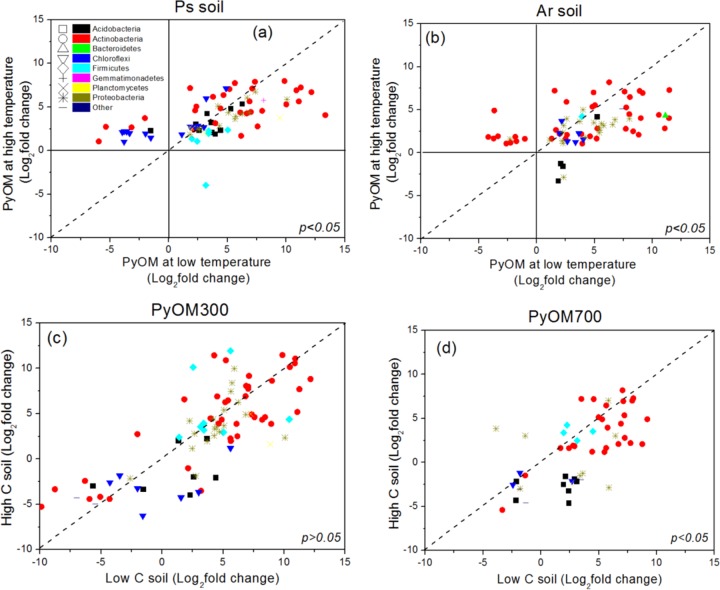
Log2-fold change in relative abundance of differentially abundant OTUs in PyOM300 and PyOM700 (a and b) and in Ps soil and Ar soil (c and d). Each dot represents a single OTU. Differentially abundant OTUs that were not significantly different (with Log2-fold change of <1 or adjusted P values of >0.1) compared with soil control are not presented in each figure. Dashed lines indicate that the preferences of OTUs for low- and high-pyrolysis-temperature PyOMs were equivalent. The OTUs indicated below the dashed lines preferred low-pyrolysis-temperature PyOM to high-pyrolysis-temperature PyOM, whereas the OTUs indicated above the dashed lines showed the opposite trend. t tests were conducted to show the statistically significant differences (P < 0.05) in the values of Log2-fold change between two PyOMs and between two soils. P values of <0.05 in panels a and b indicate that the whole bacterial community tended to thrive better on low-pyrolysis-temperature PyOM than on high-pyrolysis-temperature PyOM. P values of <0.05 in panels c and d indicate that the bacterial community tended to be more susceptible to being changed in low-C soil than in high-C soil.